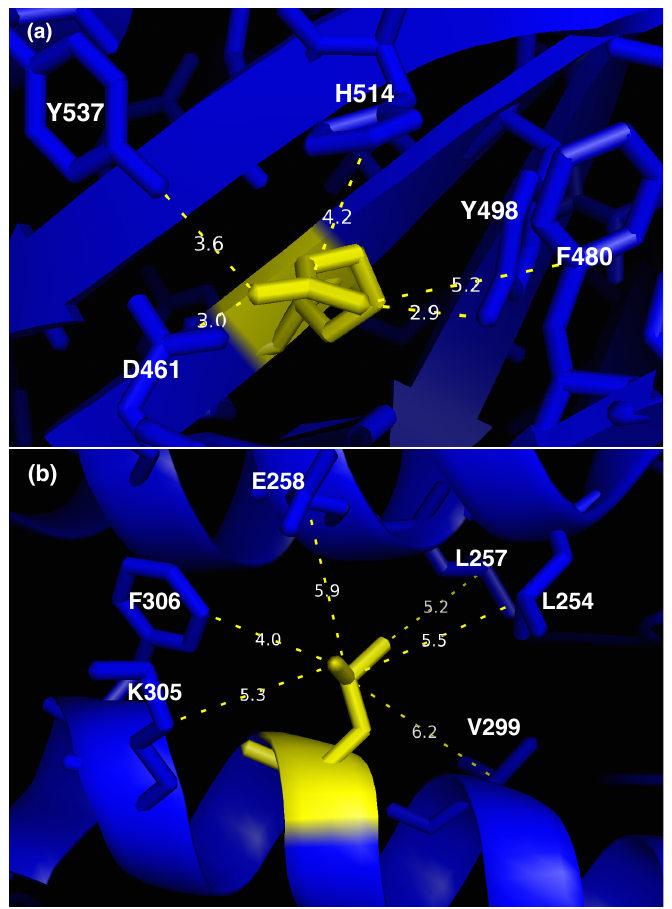
Figure 6. Spatial neighborhood and interactions of residues ( a ) Arg 496 and ( b ) Leu 302 represented in yellow